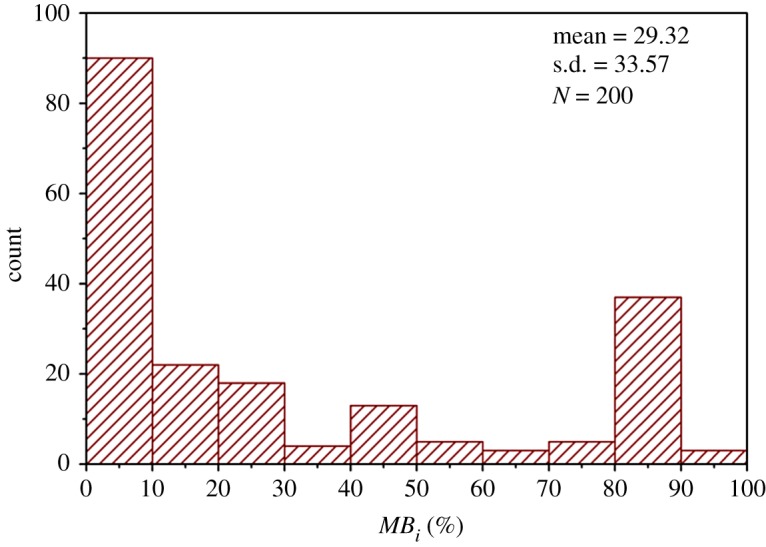
Histogram of MBi values (theoretical DFN models).